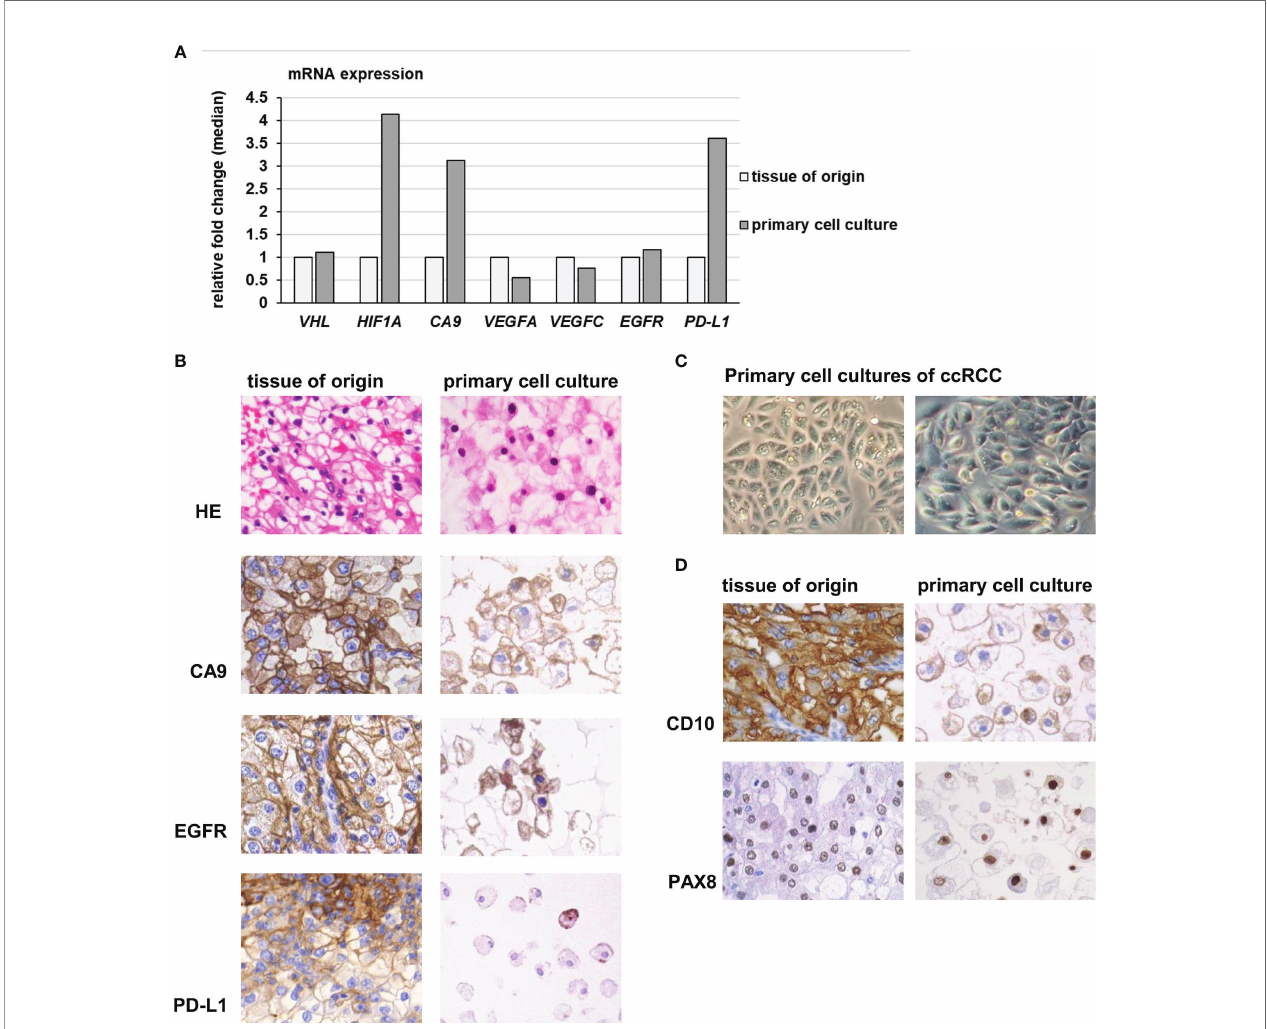
FIGURE 6 | Gene expression of hypoxia- and angiogenesis related genes in primary cell cultures. (A) Primary cell cultures of ccRCC had slightly increased mRNA expression levels of HIF-1A and CA9, compared to the tissue of origin. The mRNA expression of VHL, VEGFA, VEGFC and EGFR remained stable, while in vitro a slightly increased expression of PD-L1 was observed. (B) Primary cell cultures expressed CA9, EGFR and PD-L1 in accordance to the tissue they derived from. Especially PD-L1 protein was only partially expressed in small, isolated cell nests in tumor tissue and only in some of the primary cells (magni fi cation 400 x). (C) The cell cultures grew in characteristic epithelial nests and sheets of large polygonal tumor cells (magni fi cation 400 x). (D) The primary cell cultures as well as the tumor tissue they derived from expressed CD10, another characteristic marker of ccRCC, as well as PAX8, proving their renal-epithelial origin (magni fi cation